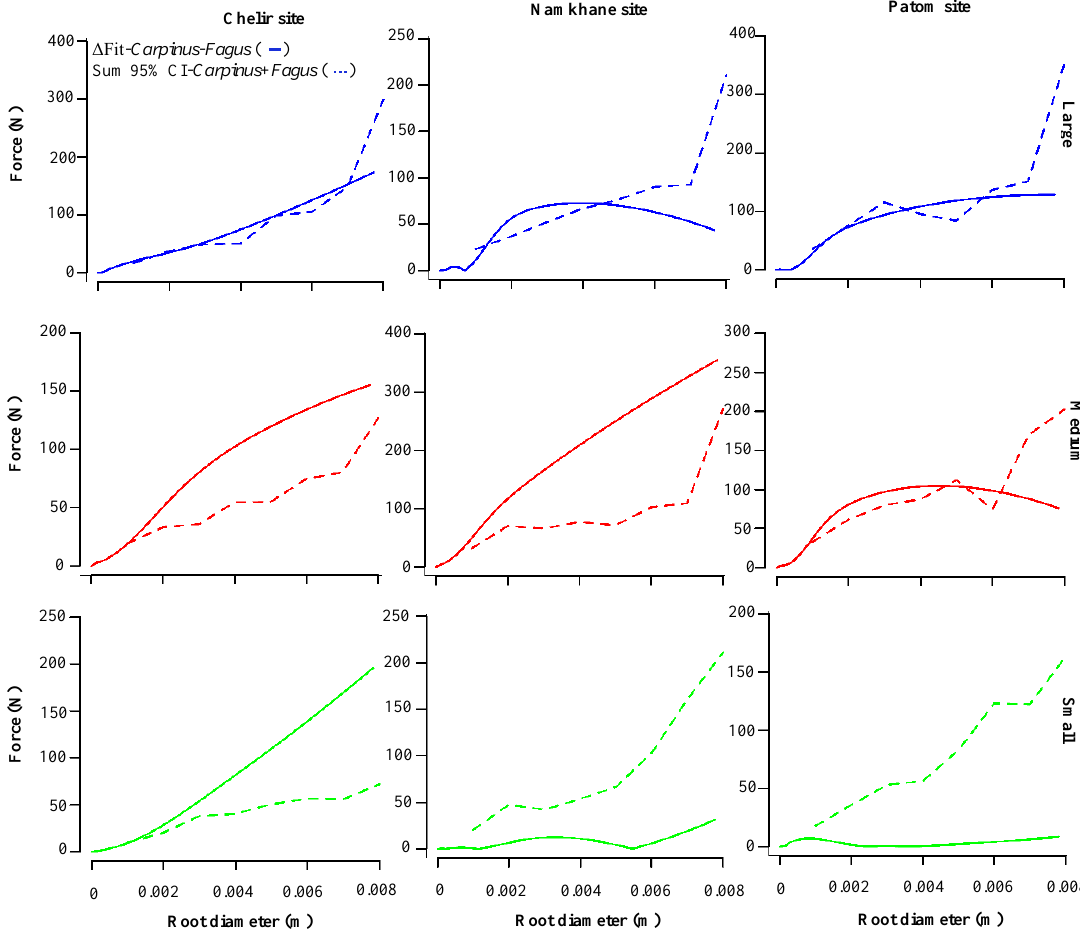
Figure 5. Calculation of difference between the fitting curves of tensile force vs. root diameter for Carpinus betulus and Fagus orientalis within three classes of diameter at breast height (DBH; small = 7.5–32.5 cm; medium = 32.6–57.5; and large = 57.6–82.5 cm) at three study sites (Chelir, Namkhane, Patom).